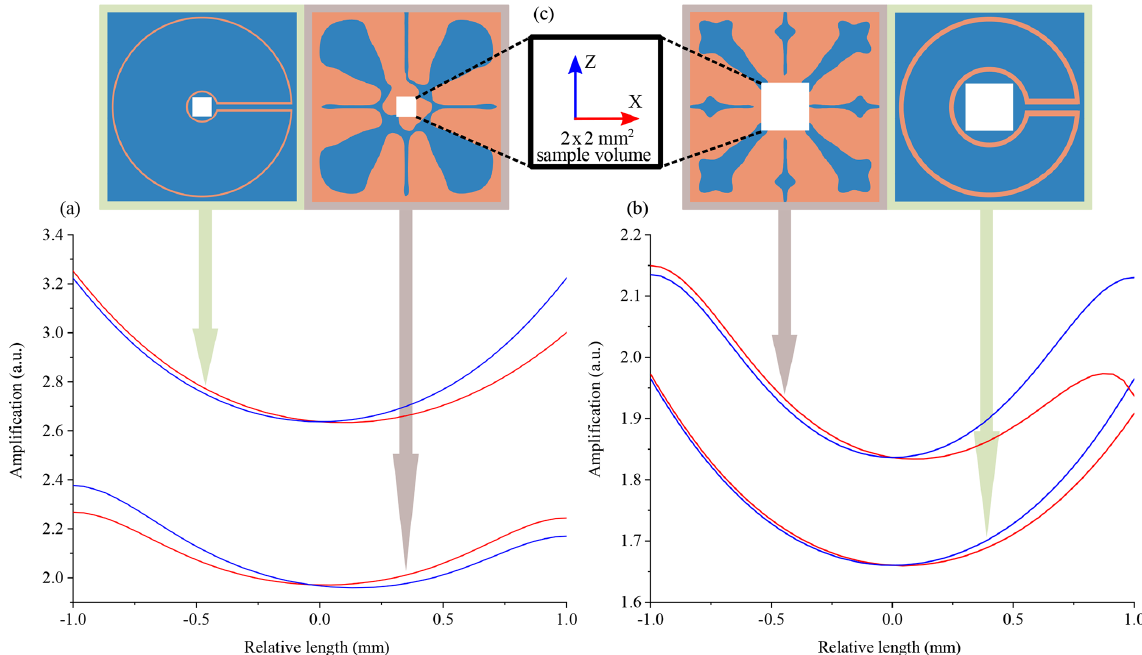
Figure 5. (a, b) Amplification profile comparison of the OL with the LL in the x – z plane in (cid:127) T . The horizontal axis represents the relative distance from the centre point of (cid:127) T , in the x and z directions. (a) The frequency of operation was 45MHz. The LL’s outer diameter was 19mm, and the ratio of the outer to the inner diameter was 5.59. (b) The frequency of operation was 500MHz. The LL’s outer diameter was 7.6mm, and the ratio of the outer to the inner diameter was 2.24. (c) The sample region in the centre of the Lenz lenses is always a 2 × 2mm